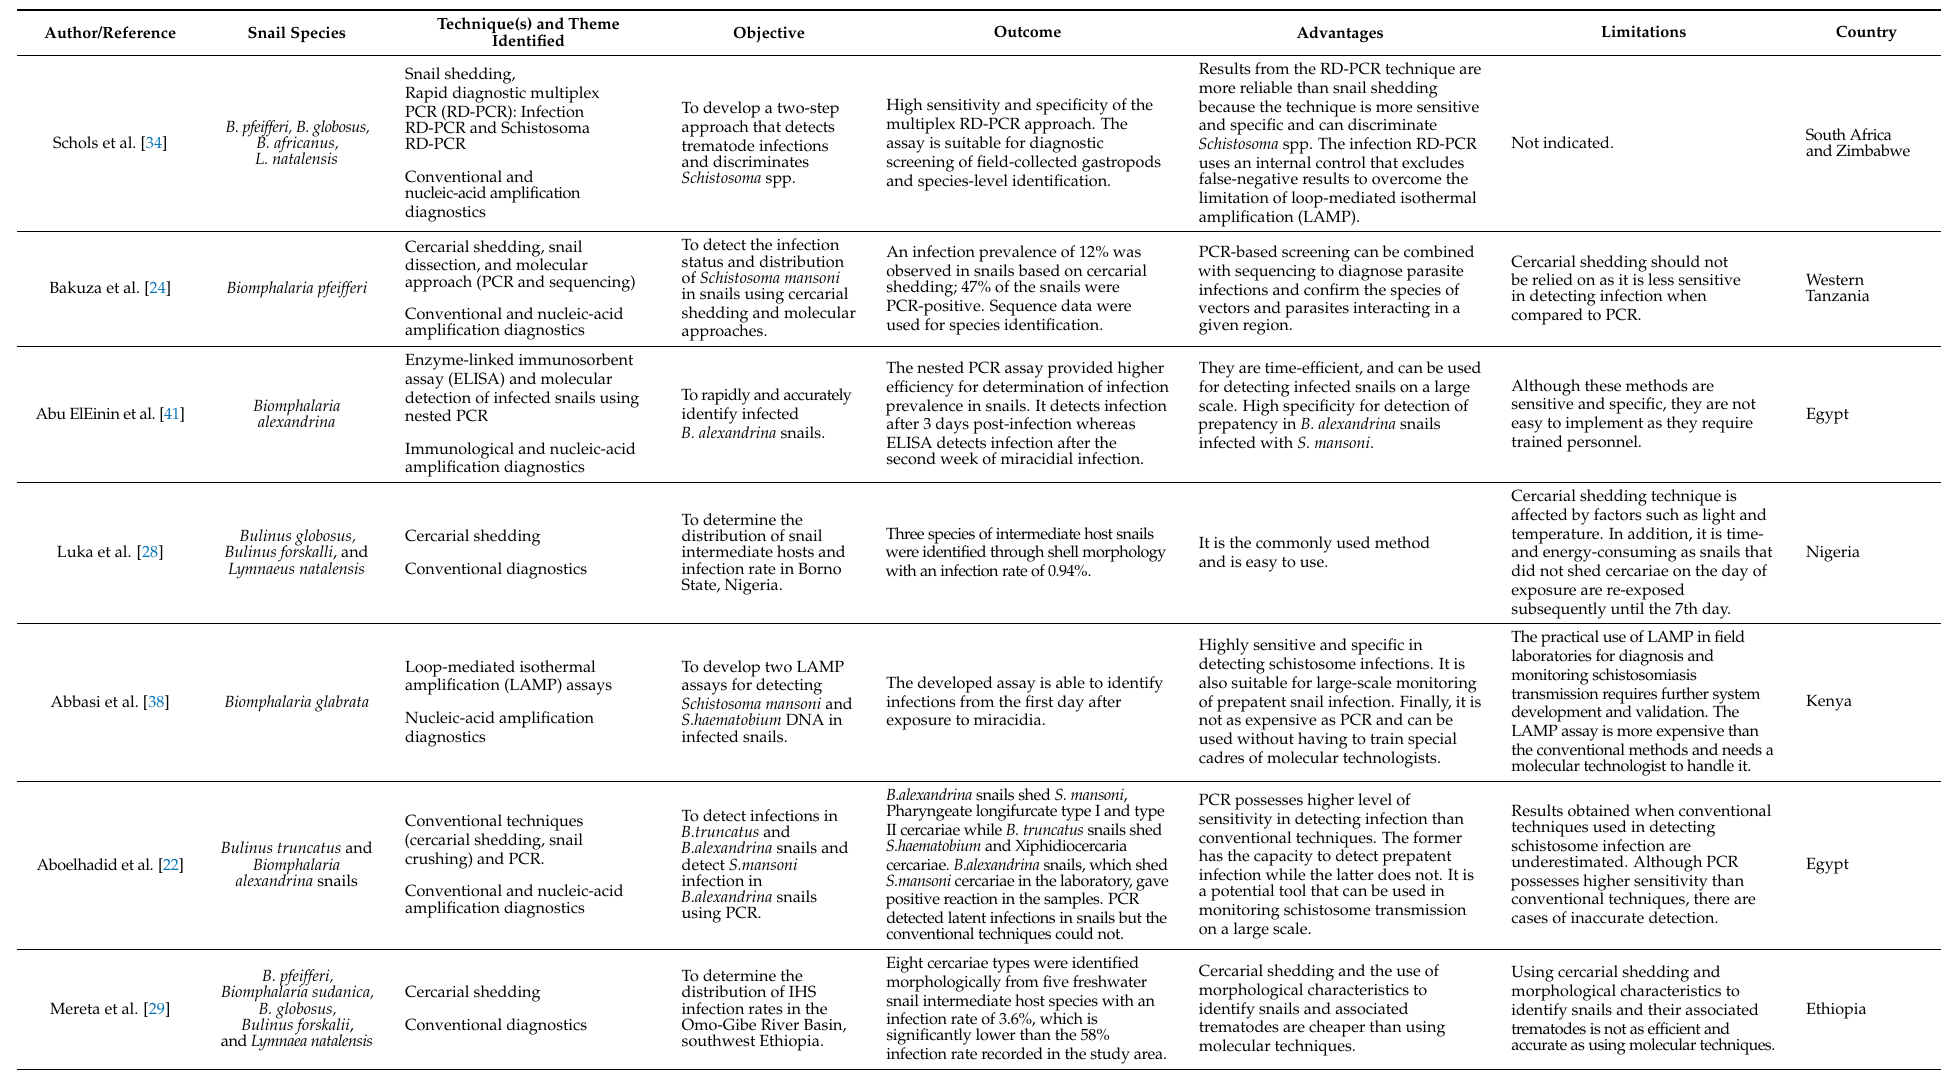
Table 1. Summary of studies that were